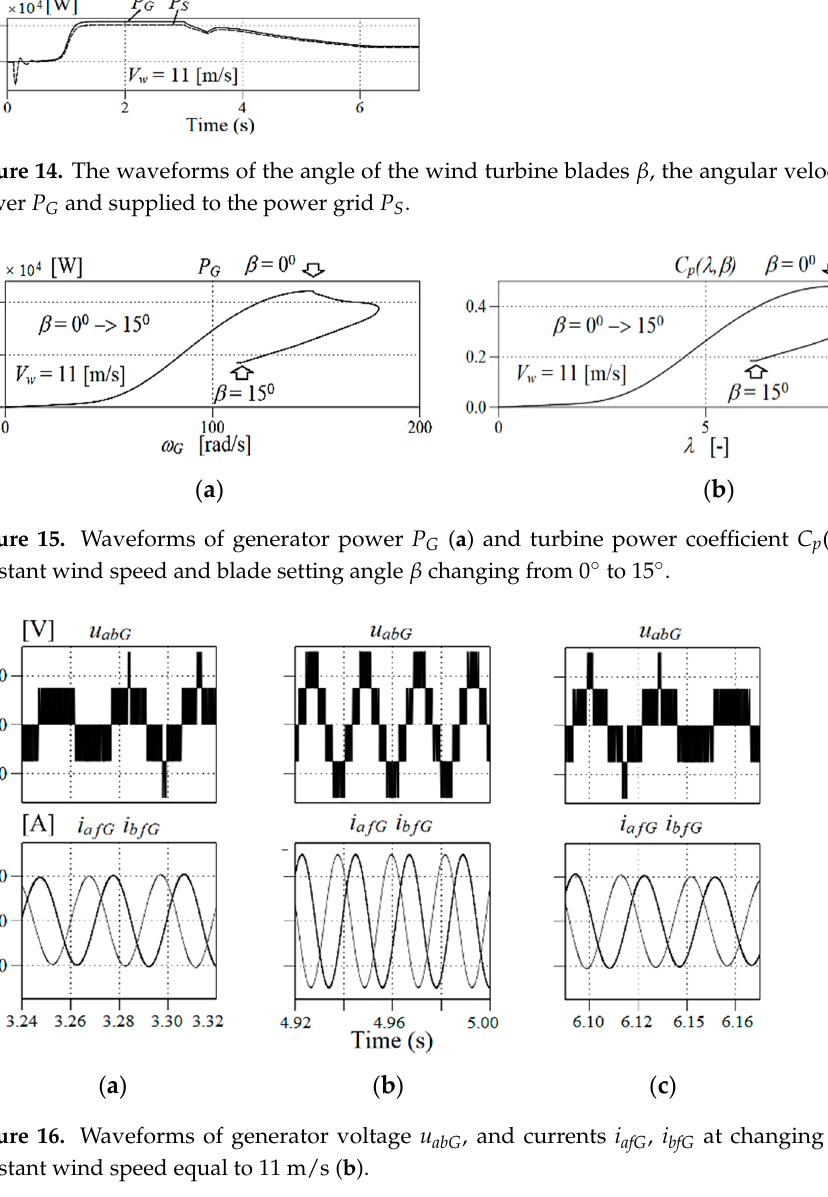
Figure 15. Waveforms of generator power P G ( a ) and turbine power coefficient C p ( λ , β ) ( b ) for con- stant wind speed and blade setting angle β changing from 0 ° to 15 ° .